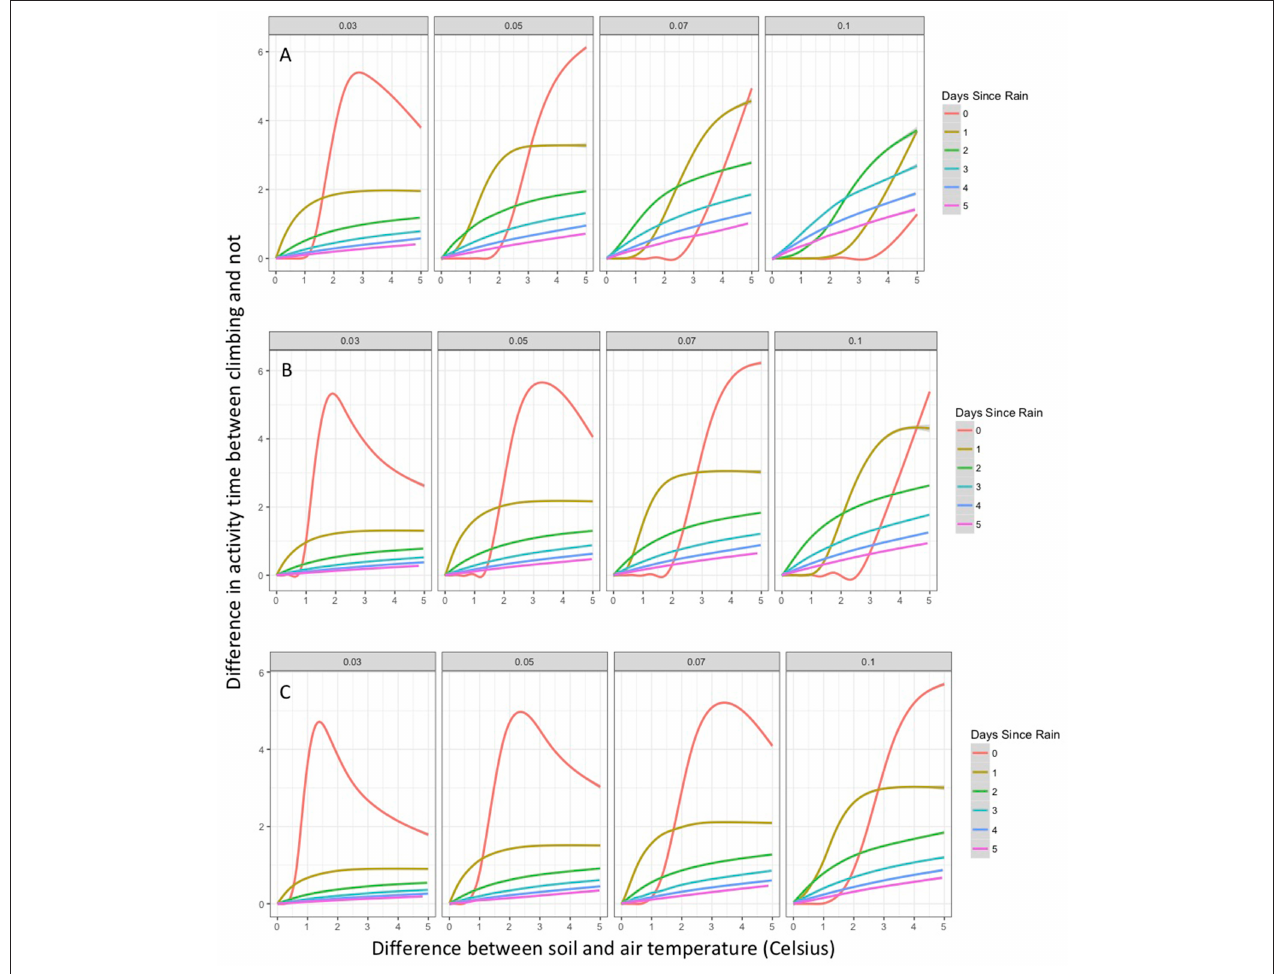
FIGURE 1 | Percent change in activity time of climbing compared to non-climbing salamanders as a function of the difference between air and ground temperature (limited to most common values), days since last rain, water loss threshold, and body size class. Shown is the generalized additive model of the percent increase in mean activity time for non-climbing salamanders compared to the mean activity time of climbing salamanders on the same simulated night. Positive value indicates greater activity time among climbing salamanders. The gray area around each line represents a 95% confidence interval. (A) adult salamanders, (B) juvenile salamanders, and (C) hatchling